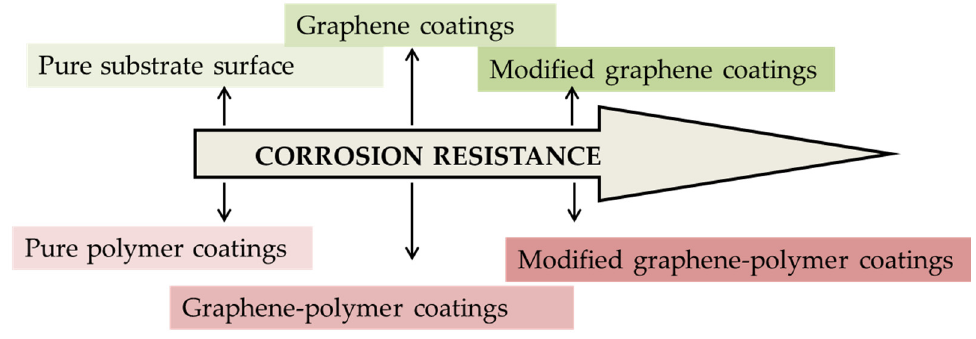
Figure 5. The direction of development of anticorrosive protective coatings.